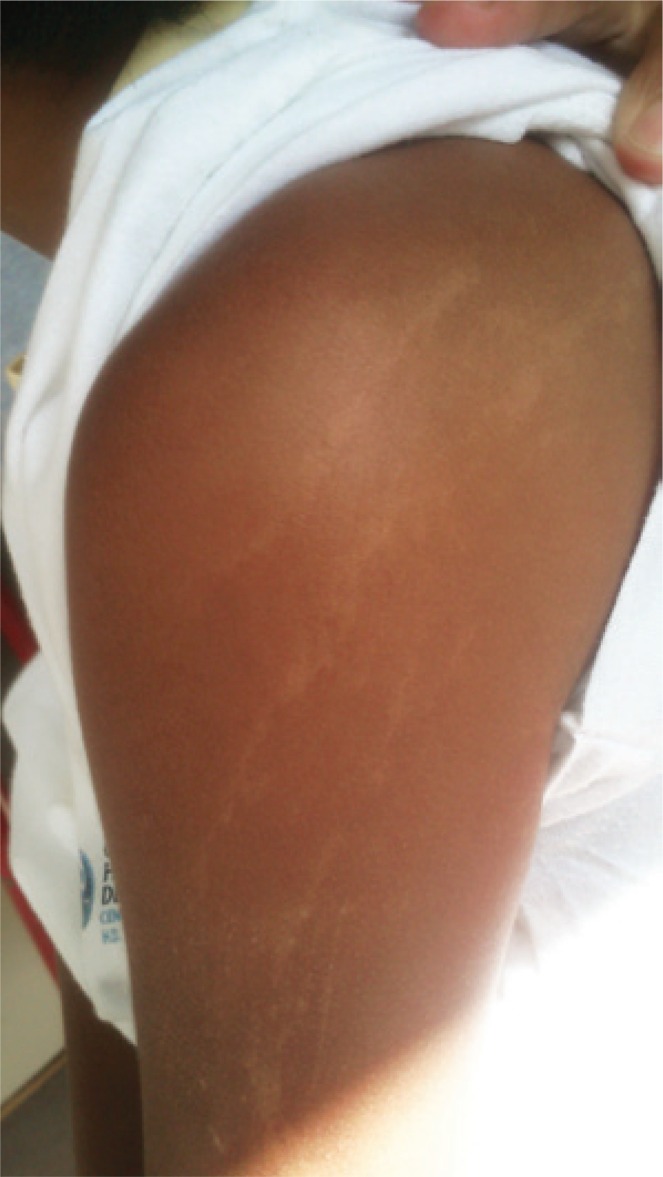
Manchas hipopigmentadas no membro superior, segundo as linhas de Blaschko